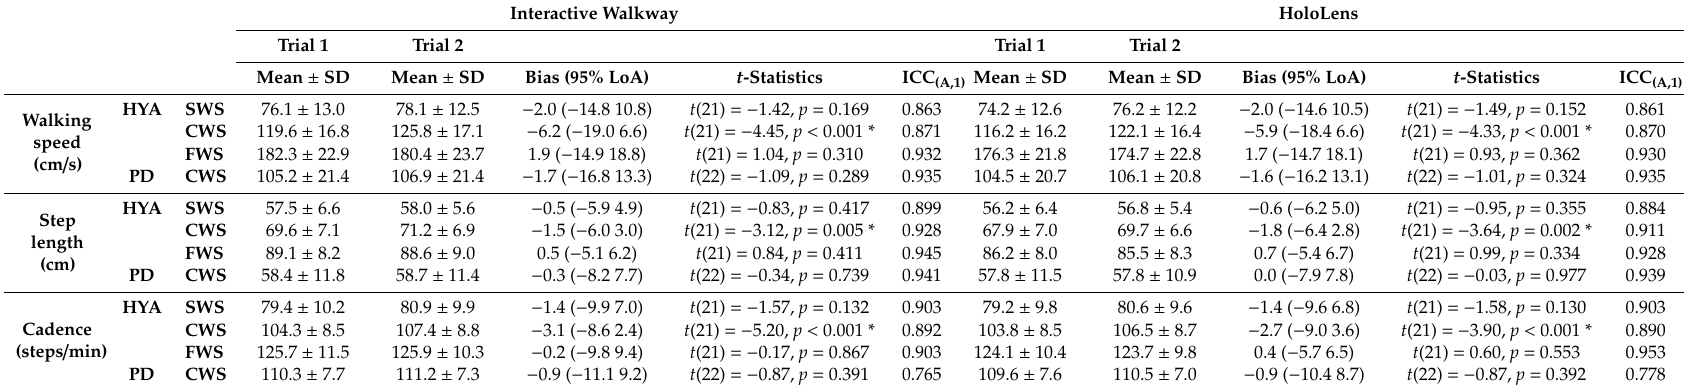
Table 2. Test-retest reliability for spatiotemporal gait parameters of instructed slow walking speed (SWS), comfortable walking speed (CWS) and fast walking speed (FWS) conditions in healthy young adults (HYA) and CWS in people with Parkinson’s disease (PD) derived from Interactive Walkway and HoloLens